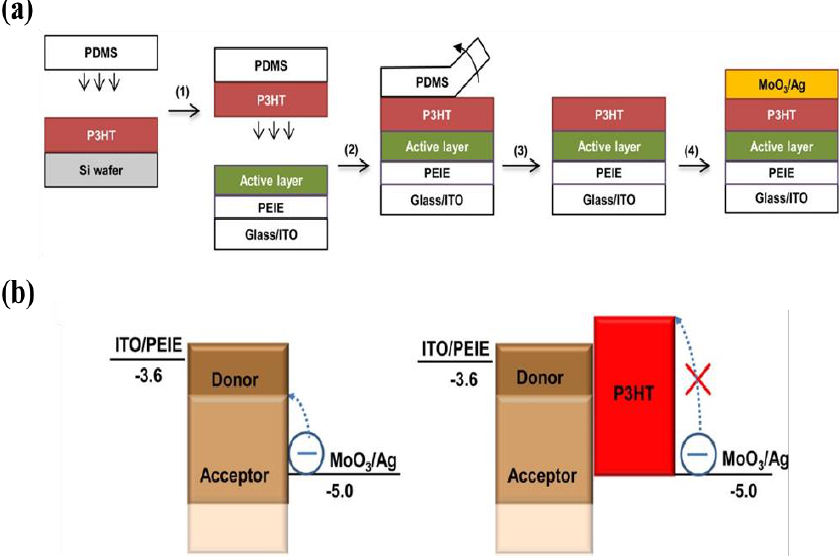
Figure 16. ( a ) Fabrication procedure and device structure of OPDs where a transfer-printed P3HT layer is used as an EBL; ( b ) A schematic demonstrates the P3HT layer blocks the electron injection under reverse bias. (Reproduced with permission from [133]. ACS Publishing, 2014).